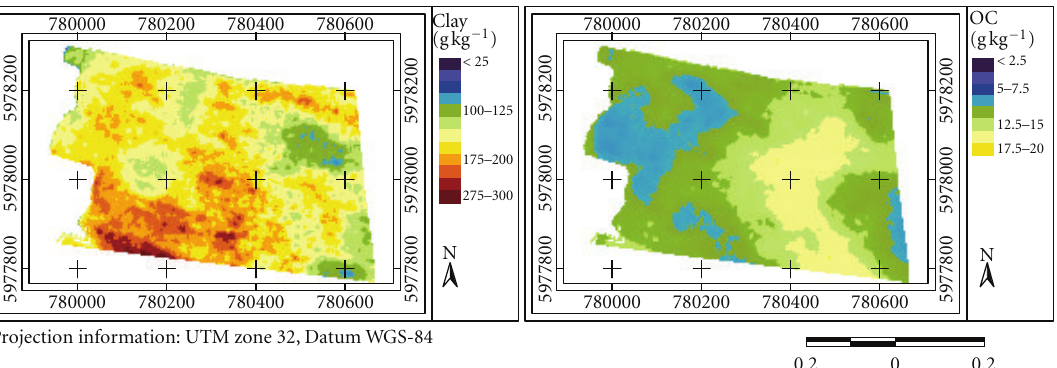
Figure 13: Map of soil clay and organic carbon content derived from HyMap image data (May 27, 2005) and PLSR for a field near the village of Heydenhof. The location of this field on the test site DEMMIN is marked by a red flag in Figure